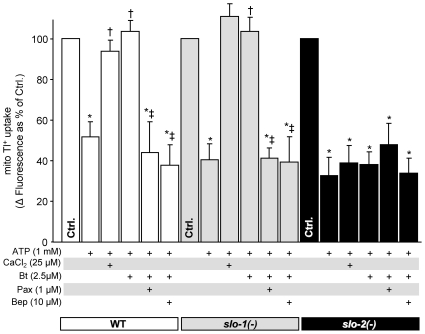

C. elegans mBK channel activity requires slo-2.
mBK channel activity in WT (N2-Bristol; white bars), slo-1 (js379; gray bars) and slo-2 (nf100; black bars) C. elegans. The baseline Δ fluorescence (Ctrl, set to 100%) was 29±6, 31±4 and 26±4 arbitrary units in WT, slo-1 and slo-2, respectively. Pharmacologic agents were present as listed below the x-axis. Data are means ± SEM, N>4 (N = independent mitochondria preparations). *p<0.05 vs. ctrl, †p<0.05 vs. ATP, ‡p<0.05 vs. ATP+Ca2+ or ATP+Bt.